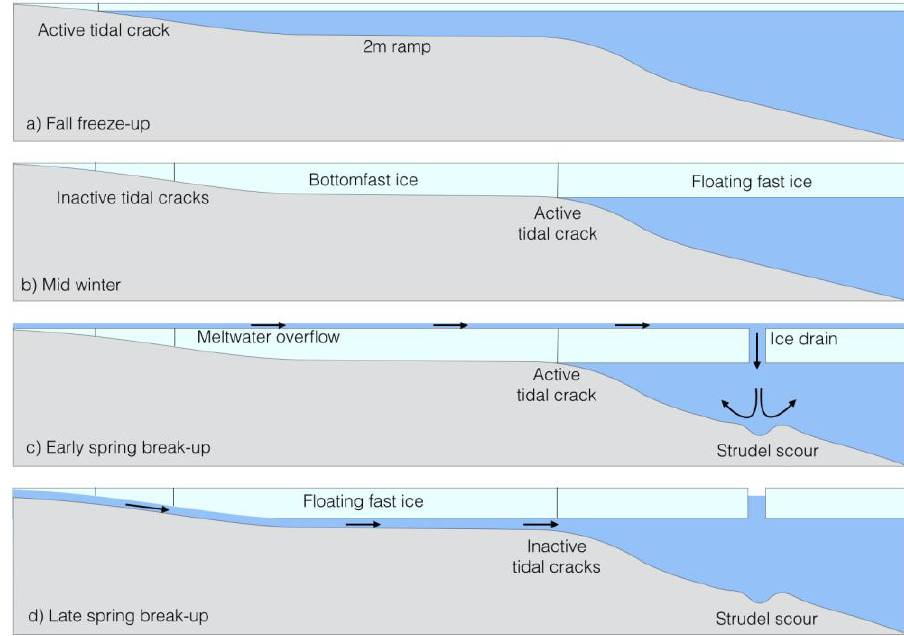
Figure 1. Schematic of seasonal evolution of bottomfast ice in a river delta where individual panels represent fall freeze-up ( a ), mid winter ( b ) , early spring break-up ( c ), and late spring break-up ( d ).